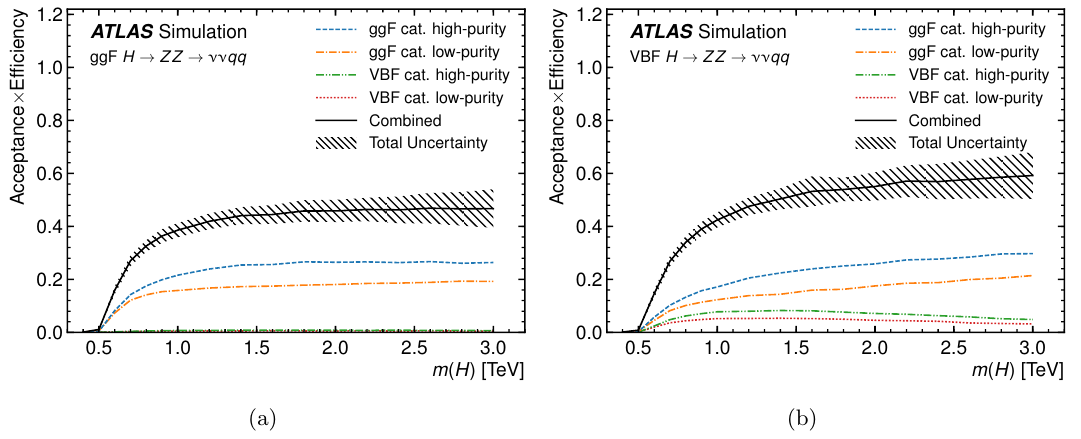
Selection acceptance times e(cid:14)ciency for the H simulations as a function of the Higgs boson mass for (a) ggF and (b) VBF production, combining the HP and LP signal regions. The hatched band represents the total statistical and systematic